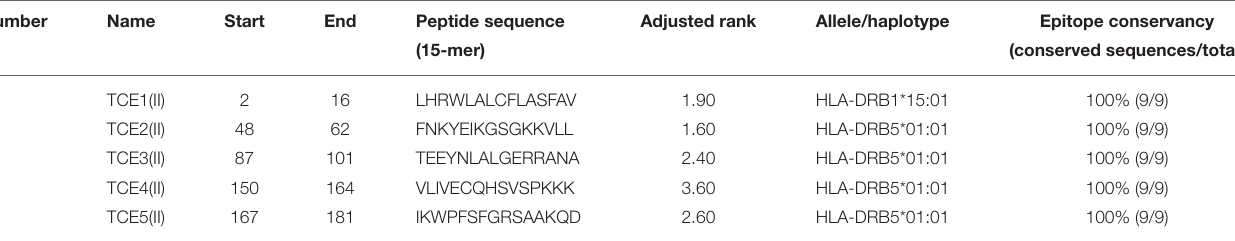
TABLE 7 | The selected best five potential epitopes binding to MHC class II alleles, on the basis of their adjusted rank predicted by the IEDB server and epitope conservancy